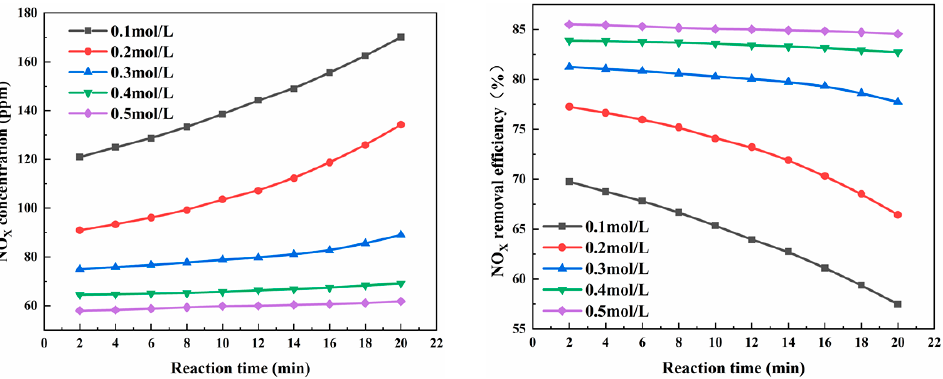
Figure 4. Effects of H 2 O 2 concentration on NO X removal efficiency.